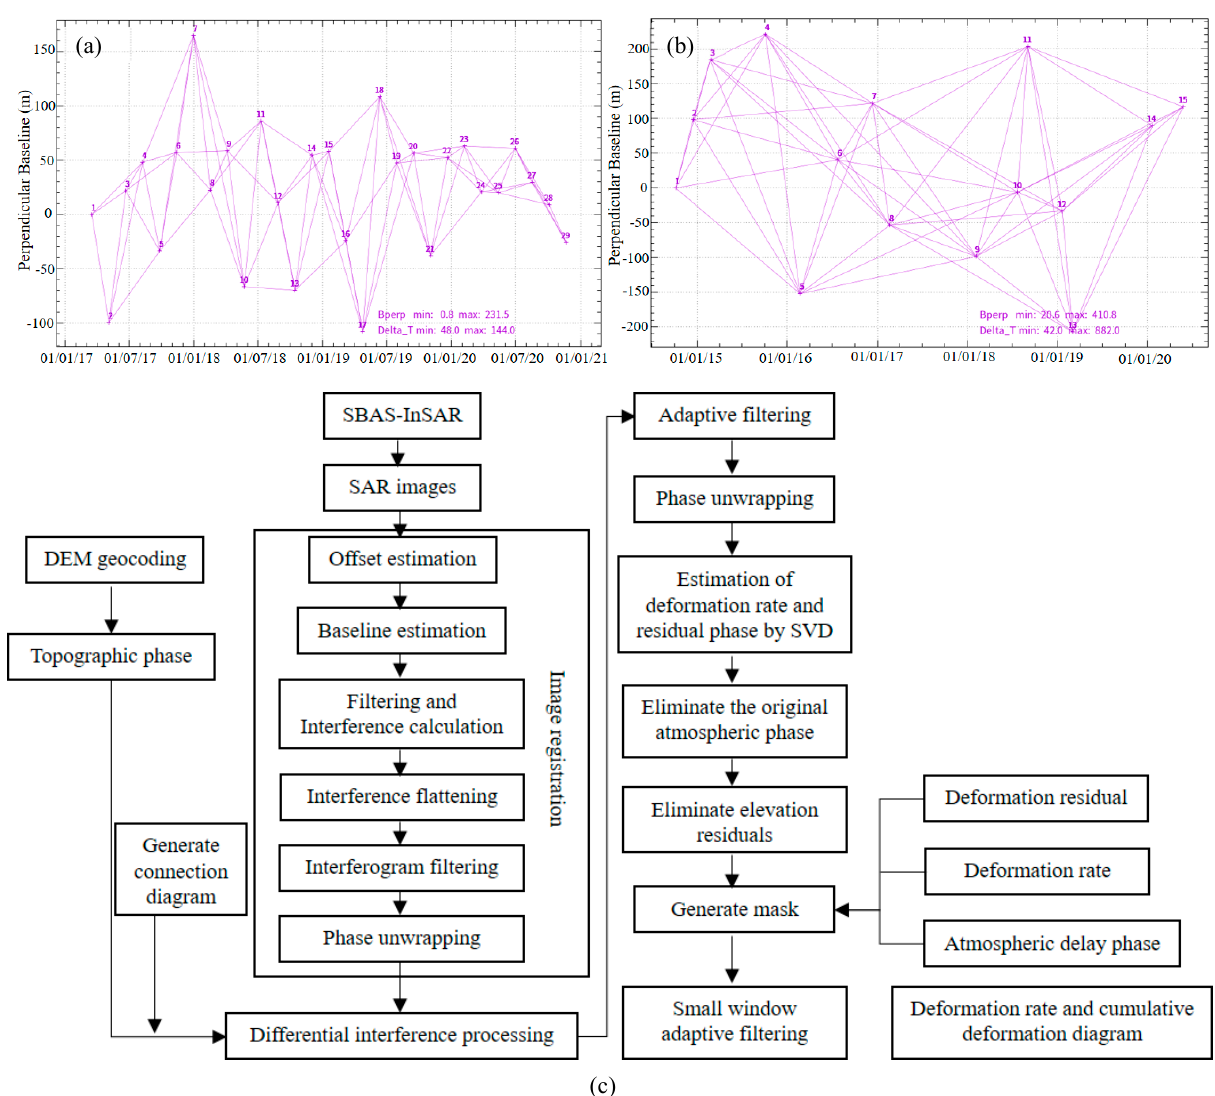
Figure 2. ( a ) Time − baseline of interferometric pairs of Sentinel-1A images; ( b ) time − baseline of interferometric pairs of ALOS-2 images; ( c ) SBAS-InSAR processing flow chart.